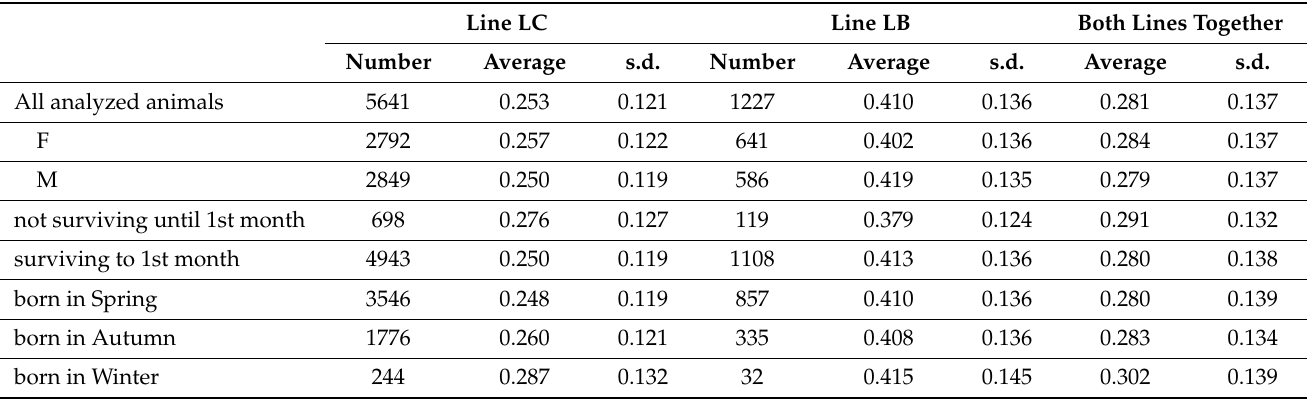
Table 2. Mean values of inbreeding coefficient of analyzed animals (with known pedigree and born in 1946–2021) divided into genetic lines.